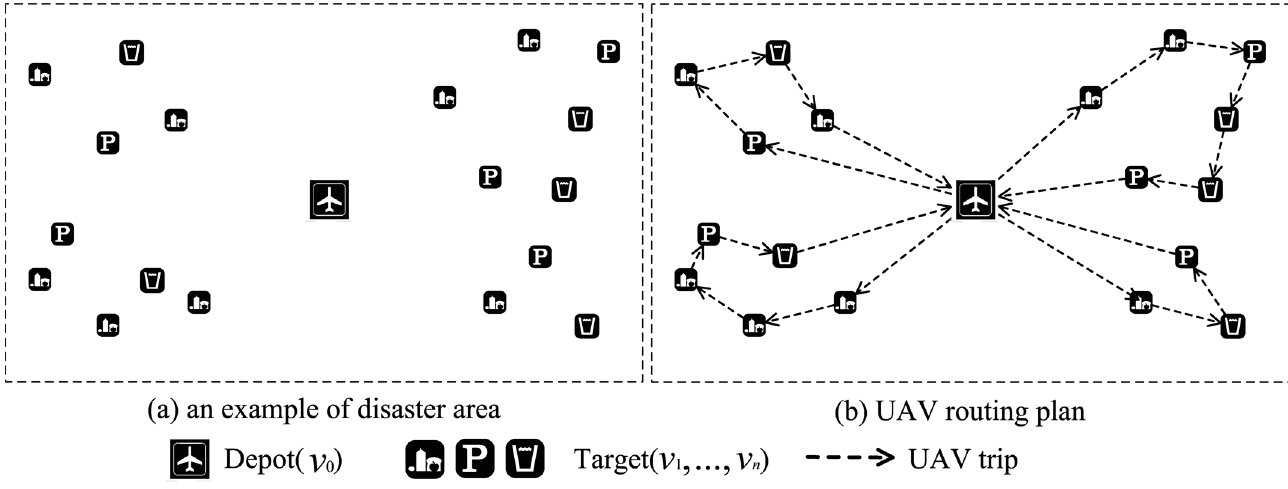
Fig 1. An example of UAV flight plan for multiple disaster